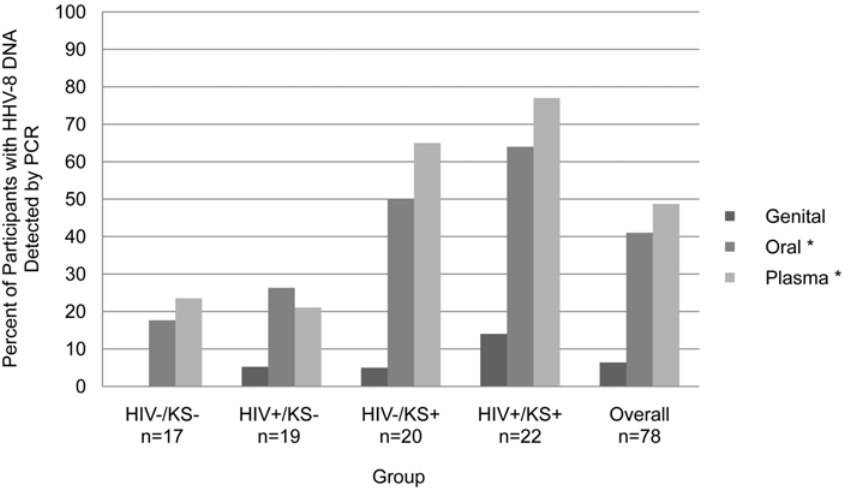
Figure 3. Proportion of participants with HHV-8 detected, by anatomic site and HIV and KS status. Percentage of participants with HHV- 8 detected from oral swabs, genital swabs, or plasma samples. Participants collected a median of 29 oral swabs, 4 genital swabs, and 5 plasma samples. *p , 0.05 for the comparison of the proportion of KS positive to KS negative participants with detectable HHV-8, using chi-square test.